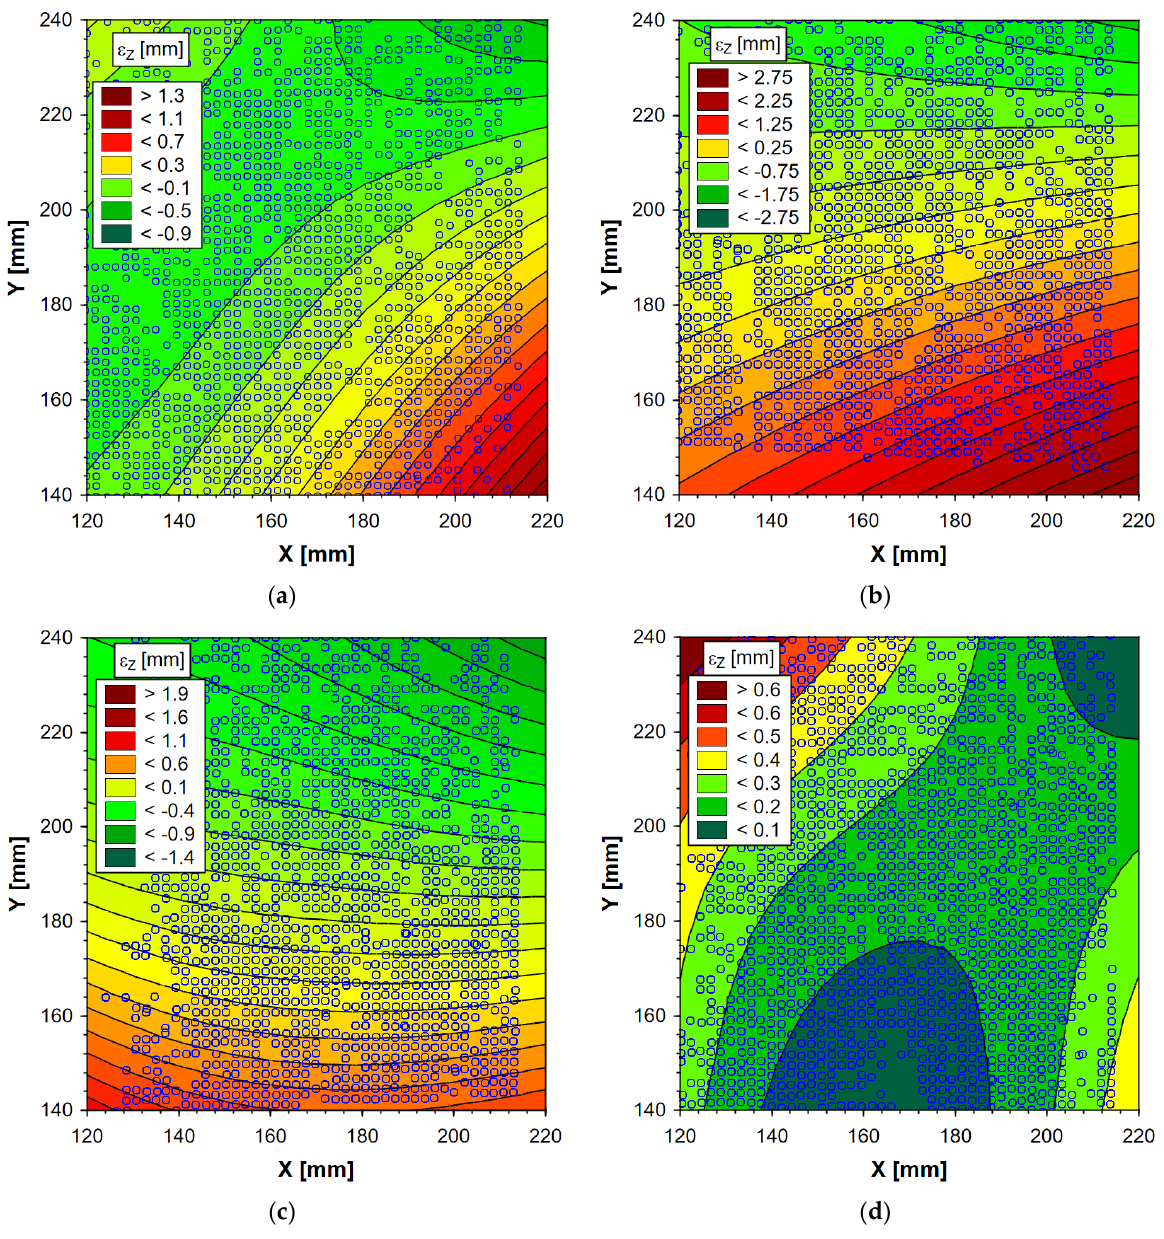
Figure 15. Distribution maps of coordinate deviations of measurement points in the direction of Z B axis of the robot base coordinate system: ( a ) measurement series 1, ( b ) measurement series 2, ( c ) measurement series 3, and ( d ) measurement series 4.